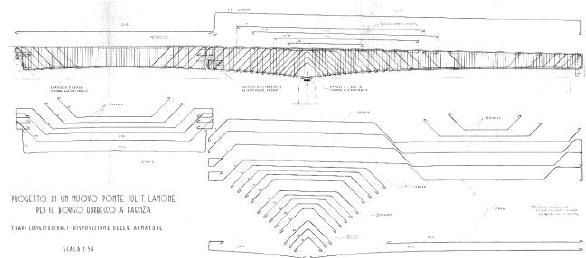
Figure 4. Main beams rebars design in the original drawing from “Archivio di Stato di Faenza”.